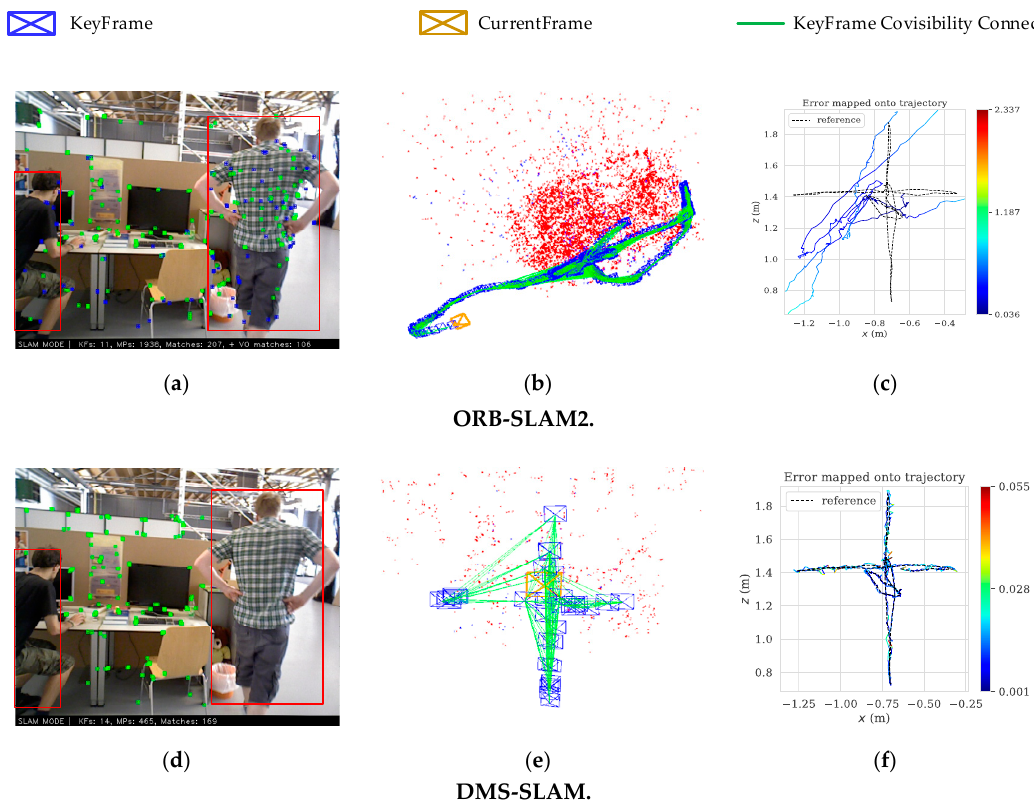
Figure 1. DMS-SLAM and ORB-SLAM2 use an RGB-D camera to locate and map on fr3_walking_xyz. ( a , d ) The image frame on fr3_walking_xyz. The red boxes represent moving objects. Green dots represent the ORB feature points corresponding to 3D points in the local map, while blue dots represent them only observed by the current frame. ( b , e ) The actual running trajectory that the camera takes during the move. The red represents the local map points which are observed in the current frame. The red and blue represent the local map points and are constructed during the tracking process. ( c , f ) The positioning deviation of the camera in the course of motion is obtained, which is based on the ground truth as the benchmark. Where “reference” represents the ground truth. The color represents the error value of the tracking trajectory and ground truth.